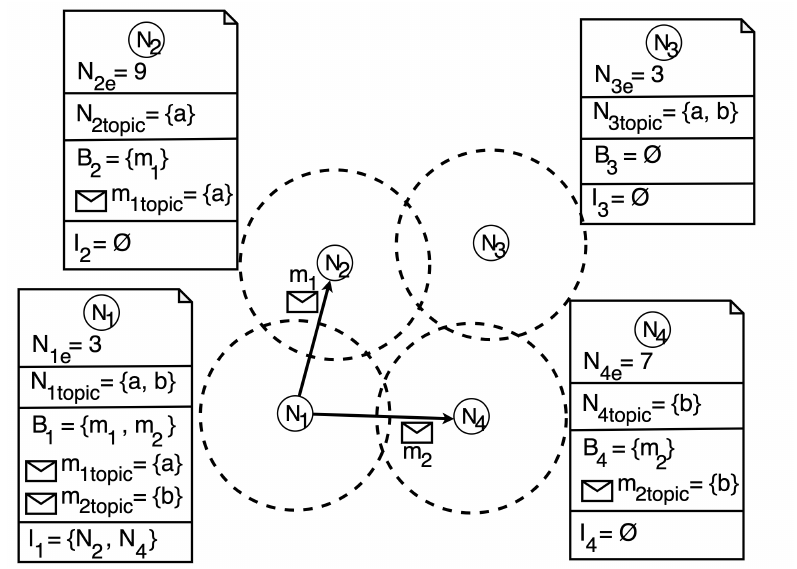
Figure 3. Broadcast based on interests and